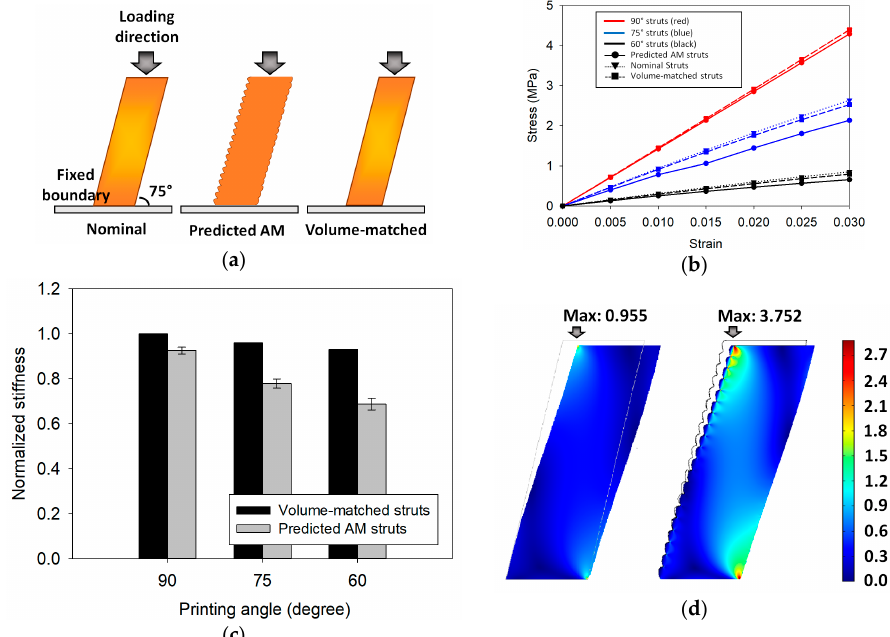
Figure 7. Compression test results of additively manufactured struts: ( a ) Loading and boundary conditions of three struts: nominal, predicted AM, and volume matched struts; ( b ) Stress–strain curve of nominal, predicted AM, and volume-matched struts in different printing angles (90 ◦ , 75 ◦ , and 60 ◦ ); ( c ) Normalized effective stiffness of volume-matched geometry and predicted AM struts in different printing angles (90 ◦ , 75 ◦ , and 60 ◦ ); ( d ) Normalized von Mises stress distributions in a predicted AM strut and a volume-matched